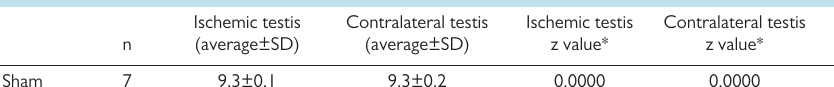
Table 3. Johnsen score averages after 4 h reperfusion